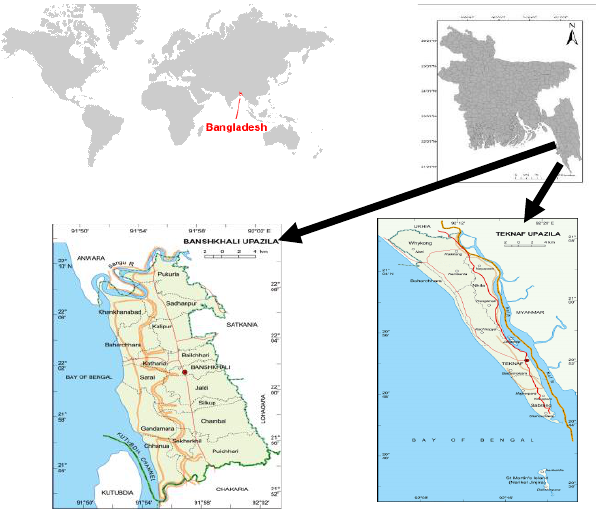
Figure 1: Geographical Location of the study areas